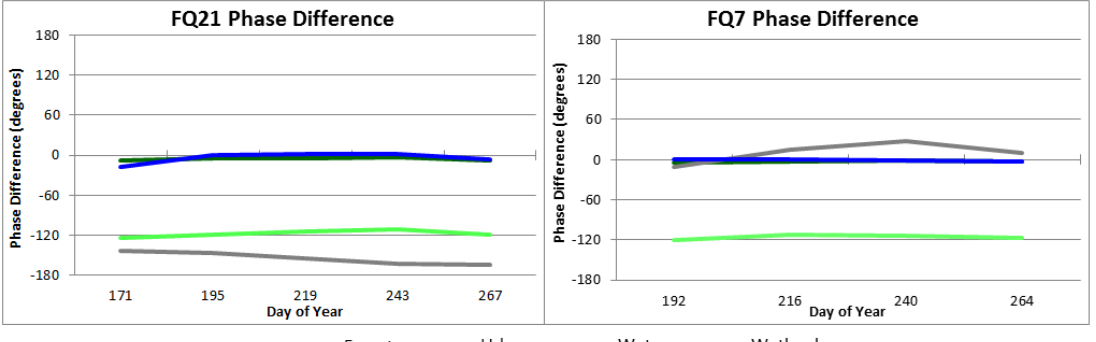
Figure 5. Co-polarized (HH-VV) phase difference for RADARSAT-2 41° ( Left ) and 26° ( Right ) incidence angles of land cover